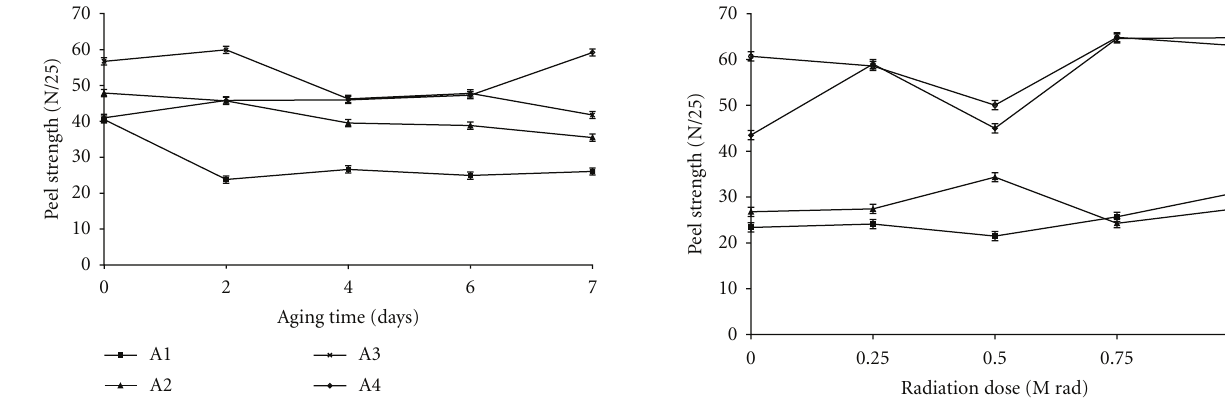
Figure 1: E ff ect of aging time on the adhesion strength between EPDM and polyester fabric.